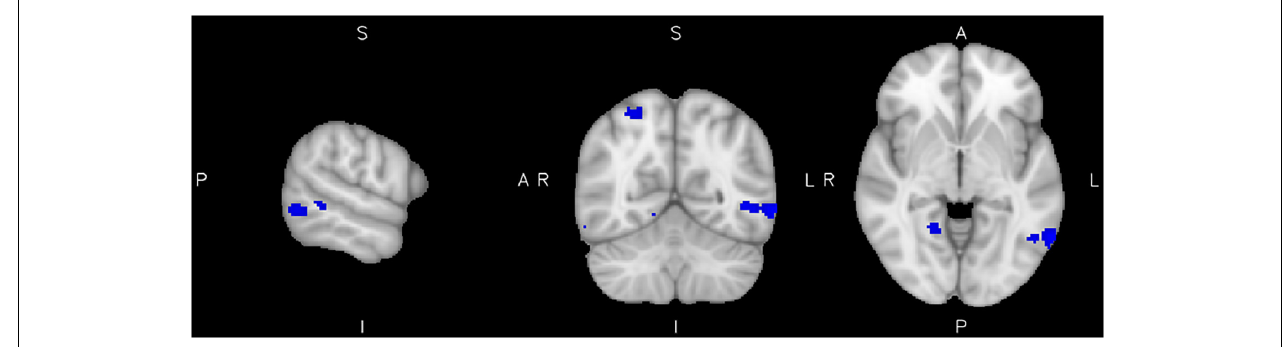
FIGURE 3 | Low reactive aggression in the control group. Results from the reactive aggression analysis of the control group at the maximum of the cluster in the left middle temporal gyrus (slices x = − 62 left, y = − 60 middle, and z = − 4 right), at a cluster extent correction of p = 0.05.